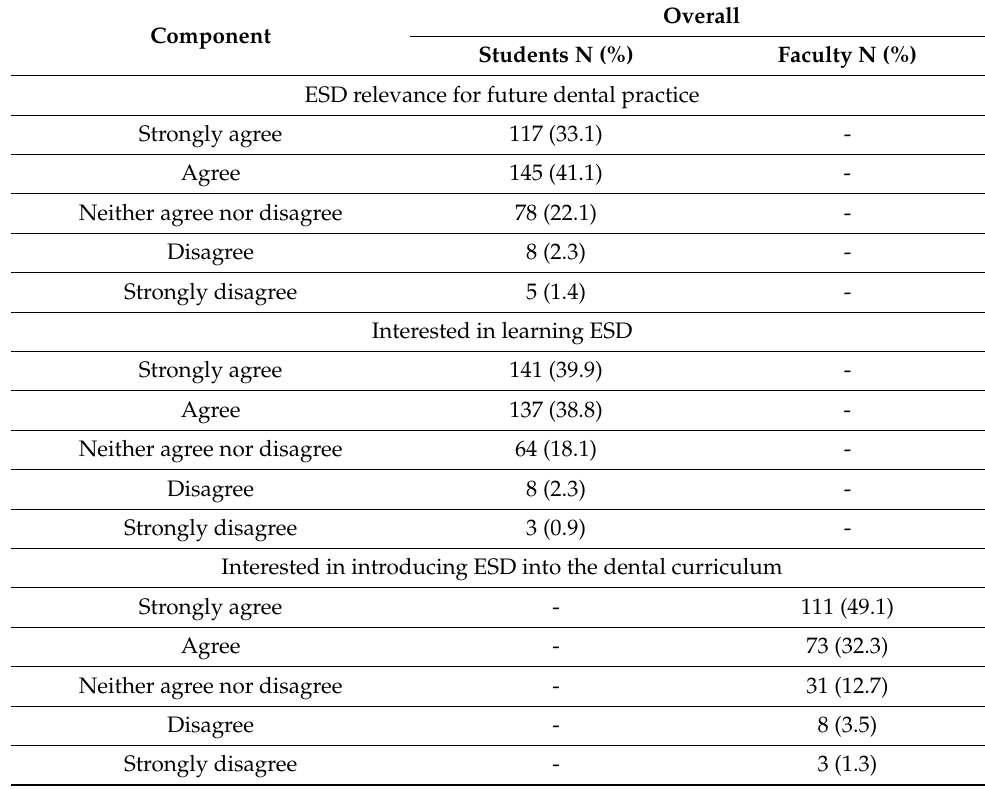
Table 3. Students’ and faculty’s interest in ESD teaching and